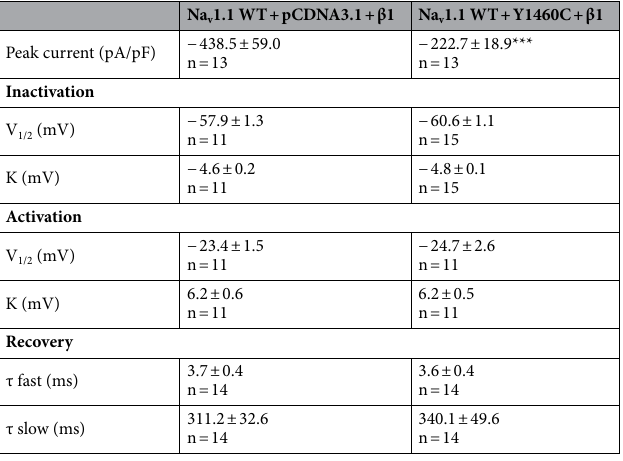
Table 1. Biophysical parameters of Na v 1.1/wild type (WT) Na v 1.1/Y1460C mutant channel. K, slope factor for activation or inactivation; τ, time constant; V 1/2 , midpoint for activation and inactivation. *** P <